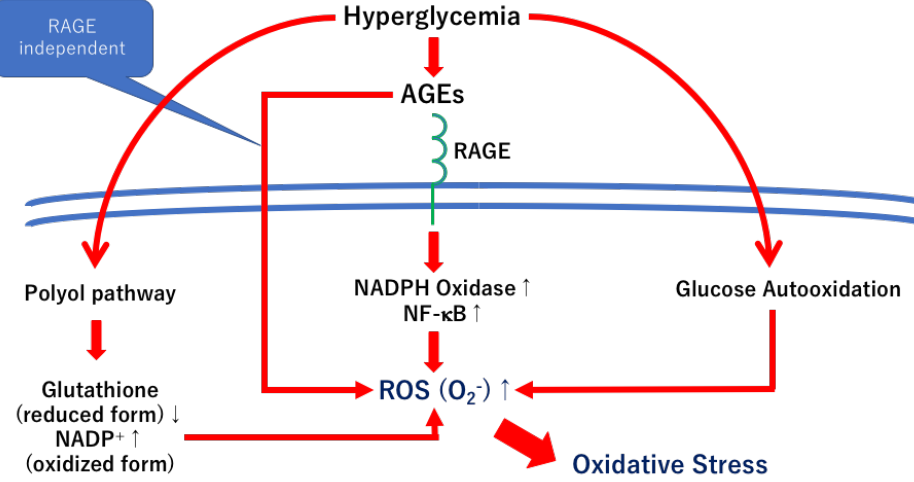
Figure 4. Hypothetic scheme of the pathophysiology of AGEs in diabetic retinas. Chronic hyperglycemia facilitates AGE production. Oxidative stress is induced by the AGE-RAGE axis, but Amadori compounds become the source of ROS production. Thus, the RAGE-independent pathways can be involved in increasing oxidative stress in diabetic retinas.